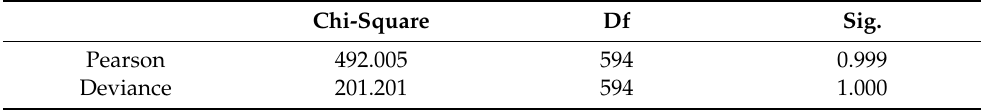
Table 6. The goodness of fit.